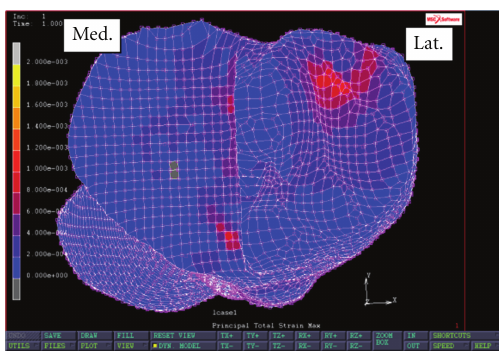
Figure 7: Maximum principal strain at implant-bone interface of a PKR knee with a frontal flange